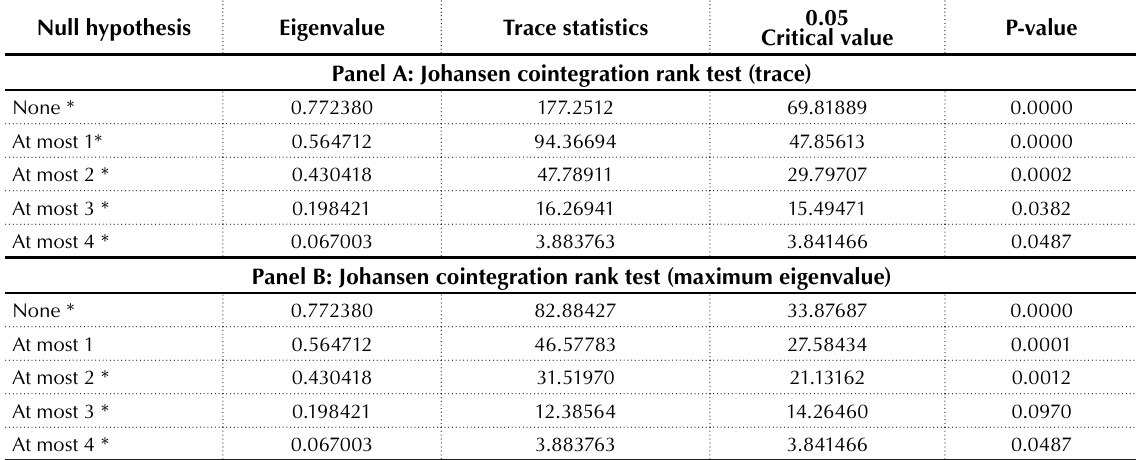
Table 6. Johansen cointegration test results Null hypothesis